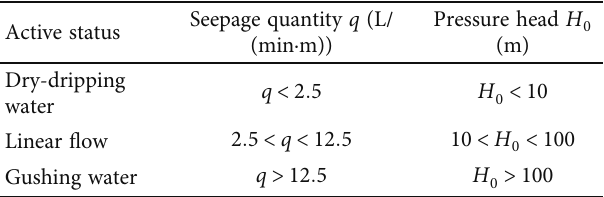
Figure 3: Water inrush phenomenon of the heading face at K28+653. Table 2: Water seepage volume and pressure head classi fi cation.